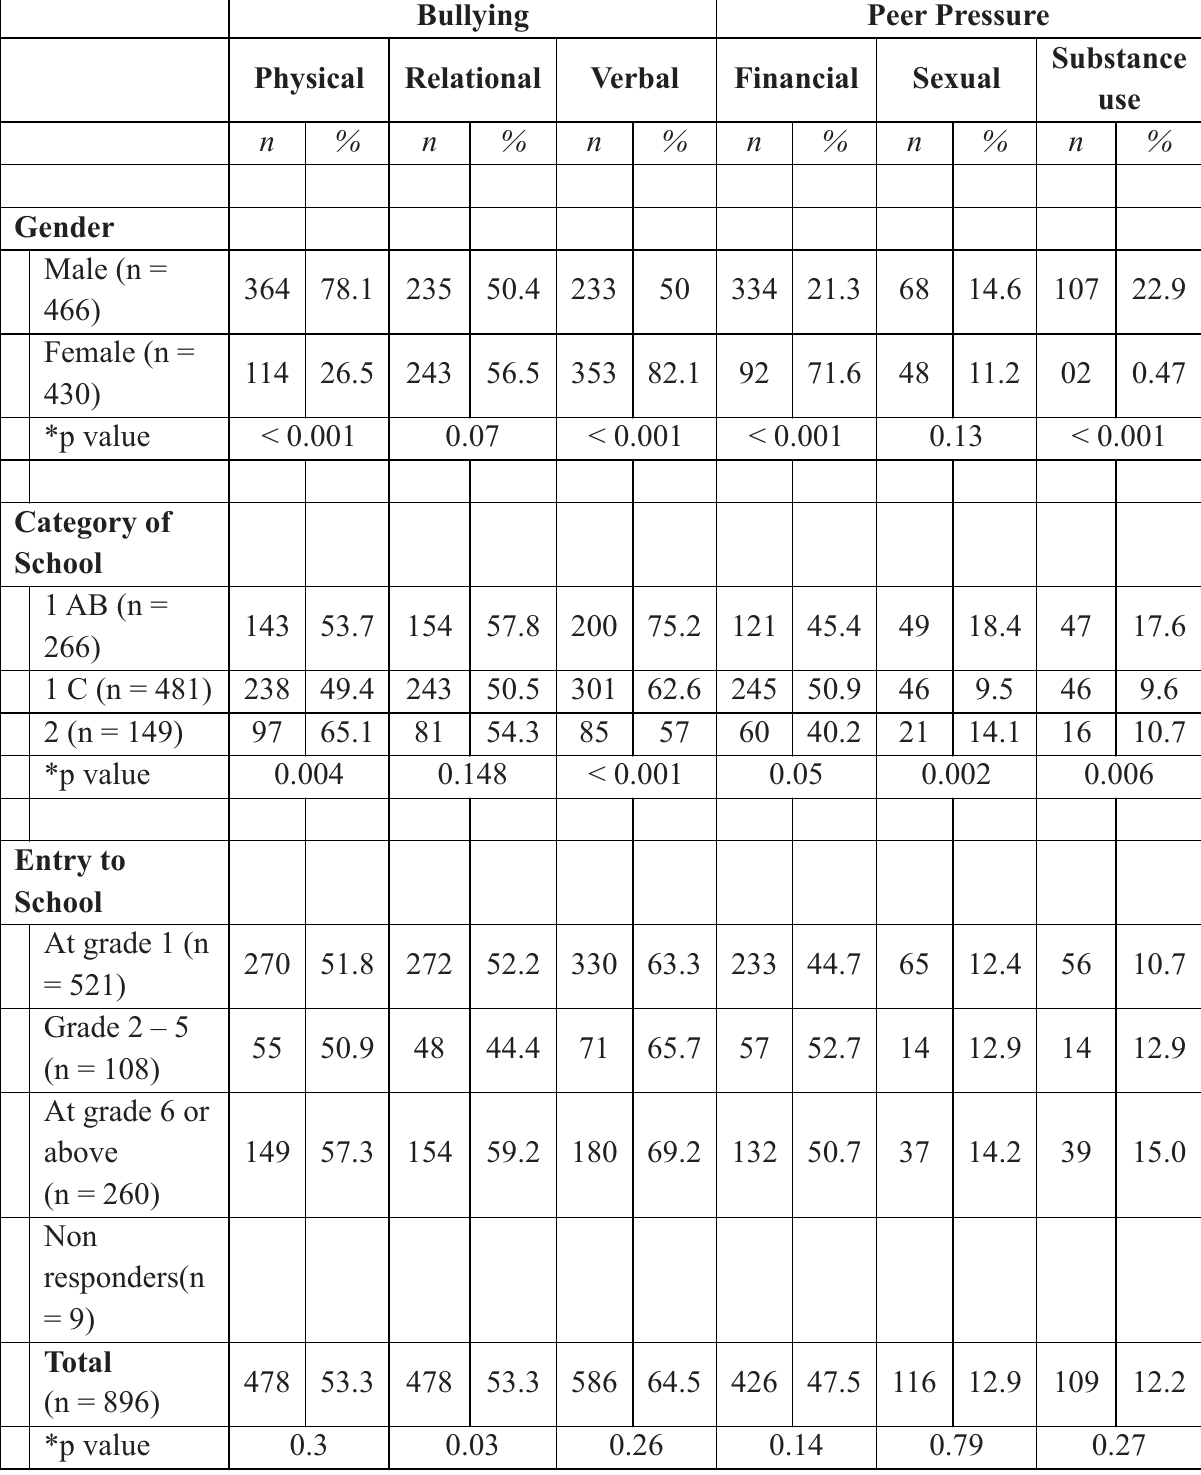
Table 3: Types of bullying and negative peer pressure according to socio – demographic characteristics of